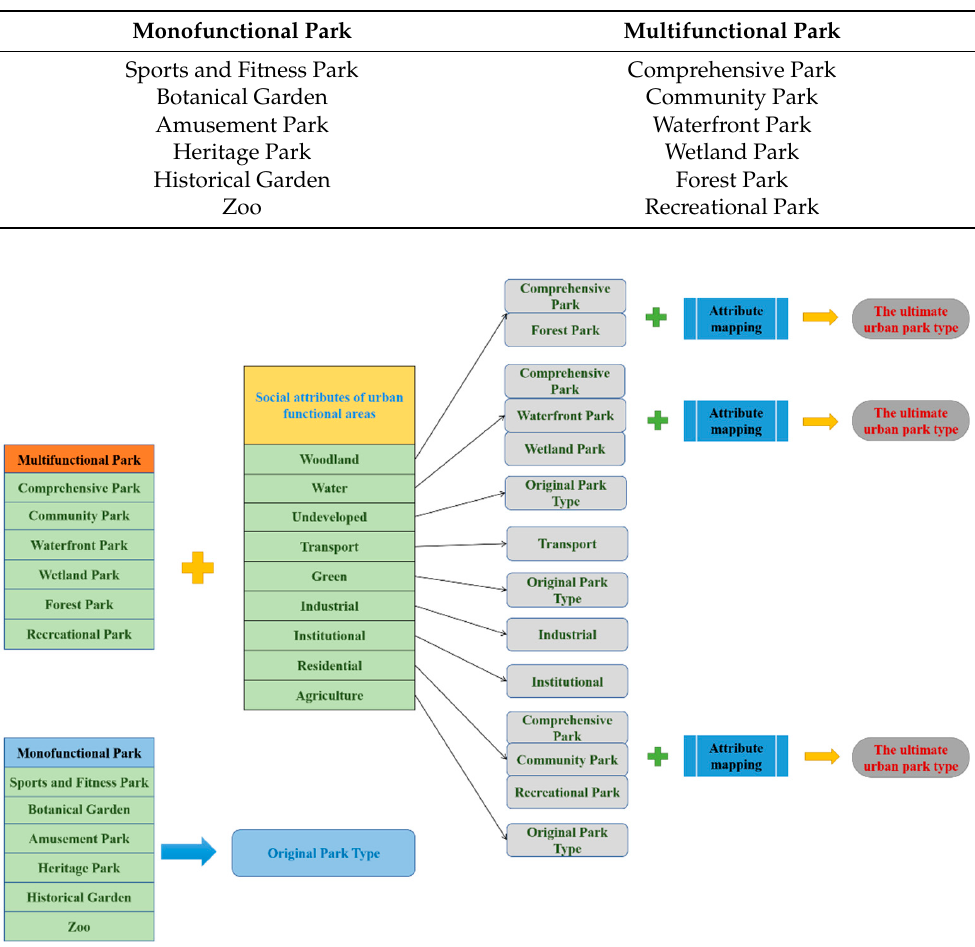
Table 4. Social attribute classification.